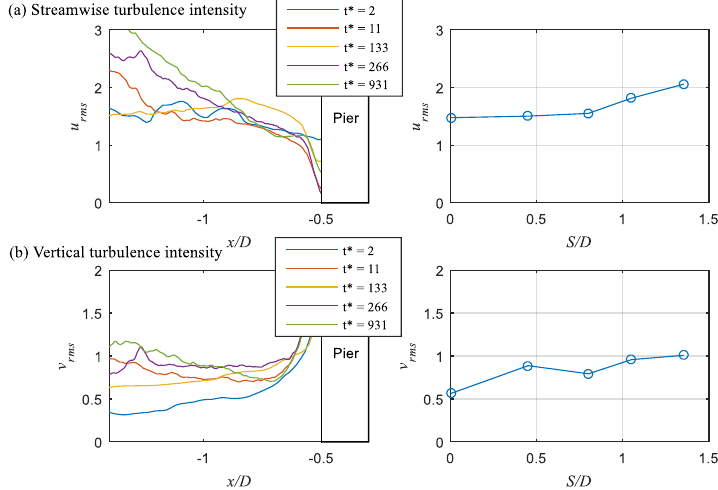
Figure 12. Turbulence intensities distributions along the center line at different time in the pier scouring process and the corresponding space-averaged value versus dimensionless pier scour depth.